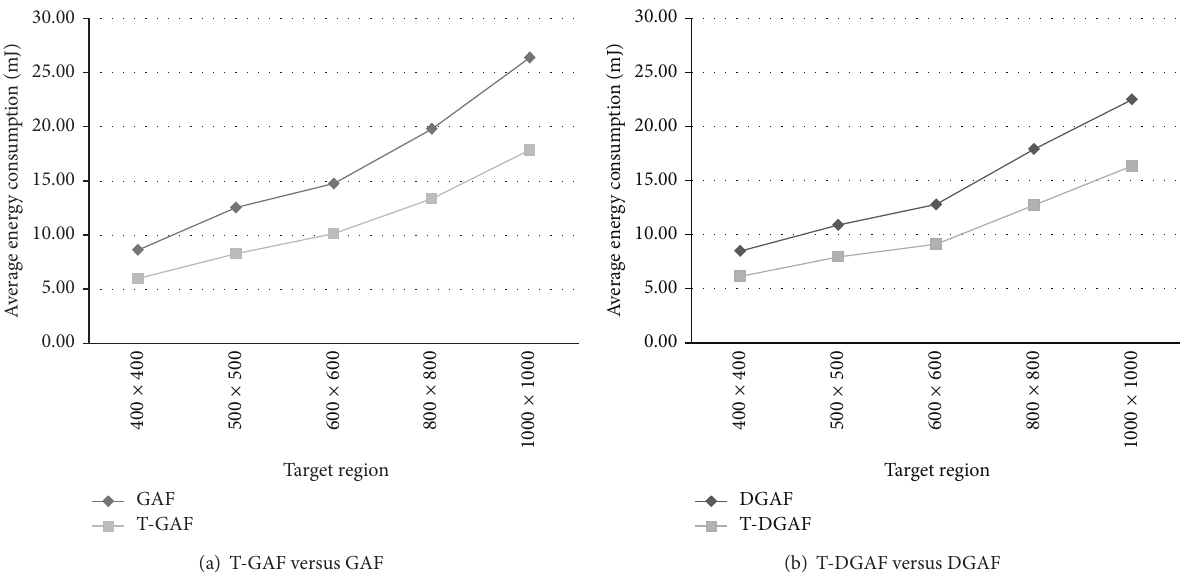
Figure 9: Comparison of the average energy consumption for different size of the target